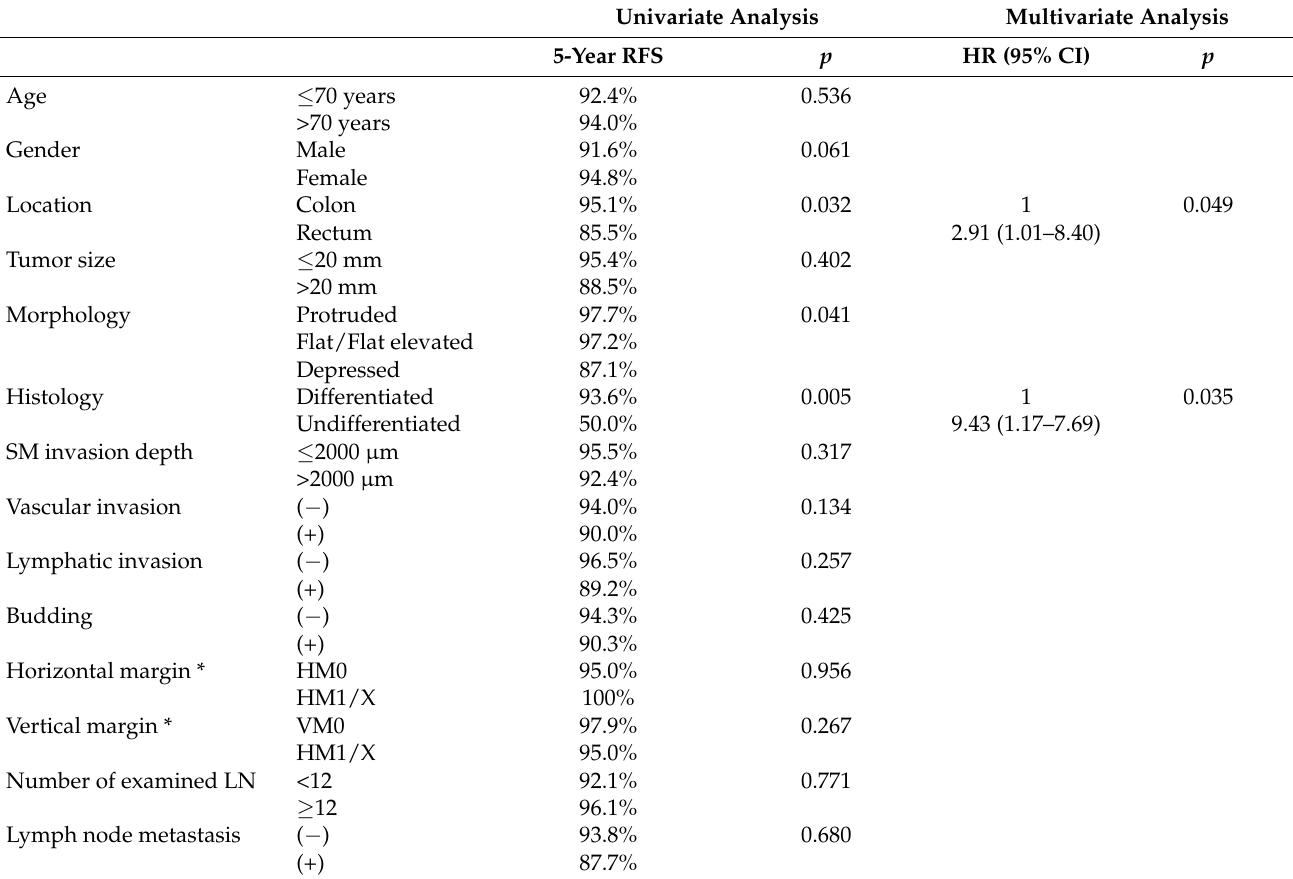
Table 4. Risk factors for relapse-free survival in the high-risk group with surgical